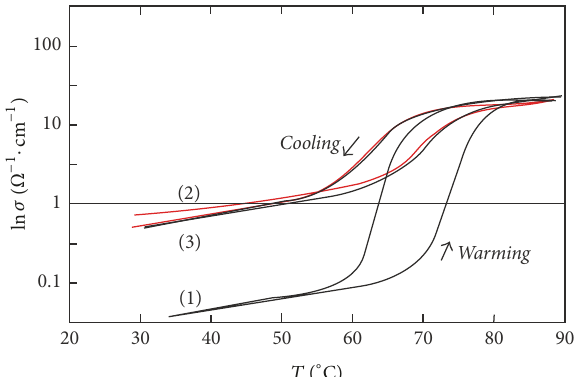
Figure 4: Conductivity temperature dependence of VO 2 film: initial sample 1 (1) , region of the film with implanted hydrogen (2) , and the same region, second measurement (3) . The implanting dose is 7.5 ⋅ 10 15 cm −2 , and the time of one 30–90–30 ∘ C thermal cycling is about 1